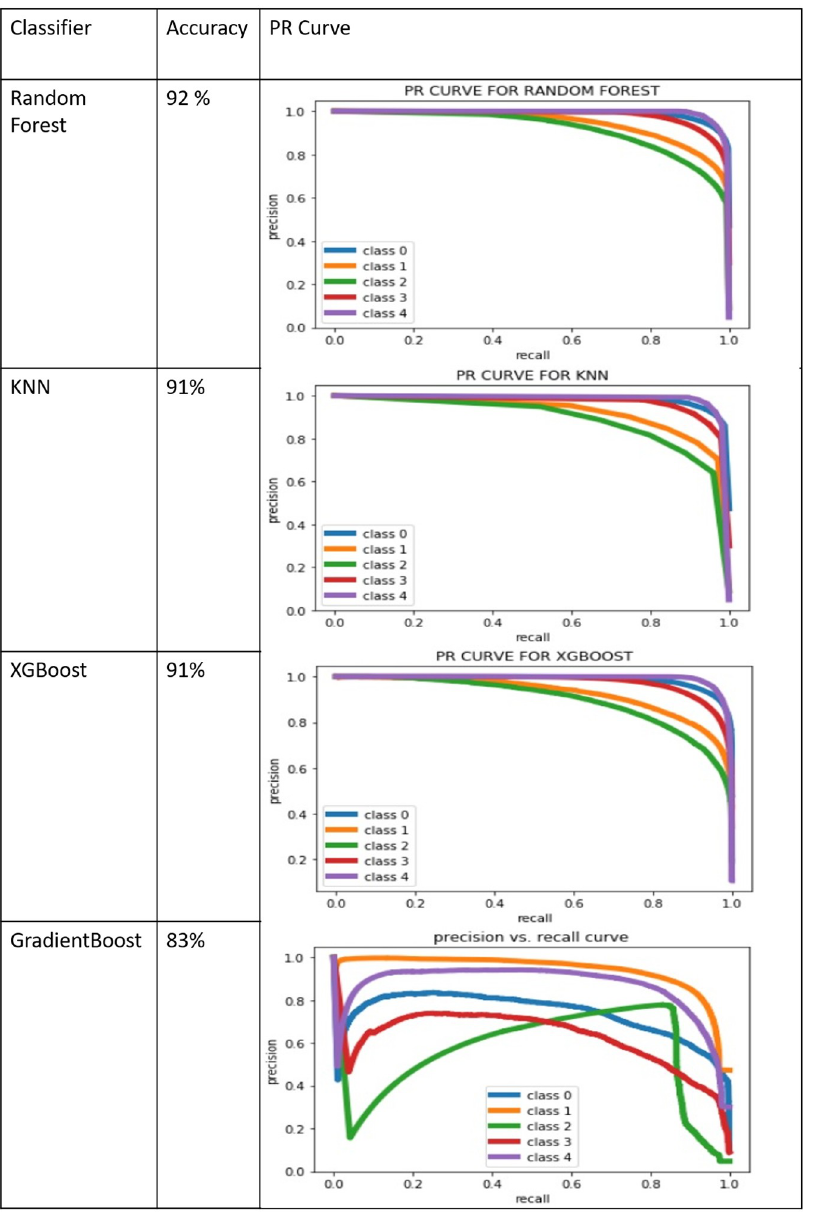
Fig 11. PR Curve for best scoring